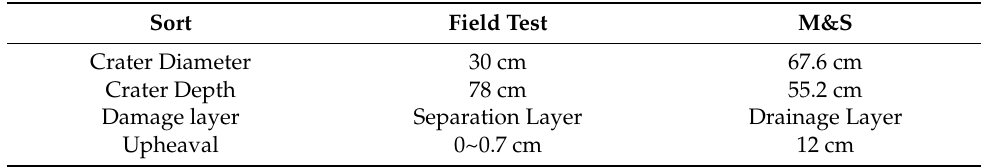
Table 6. Comparison of the field test and